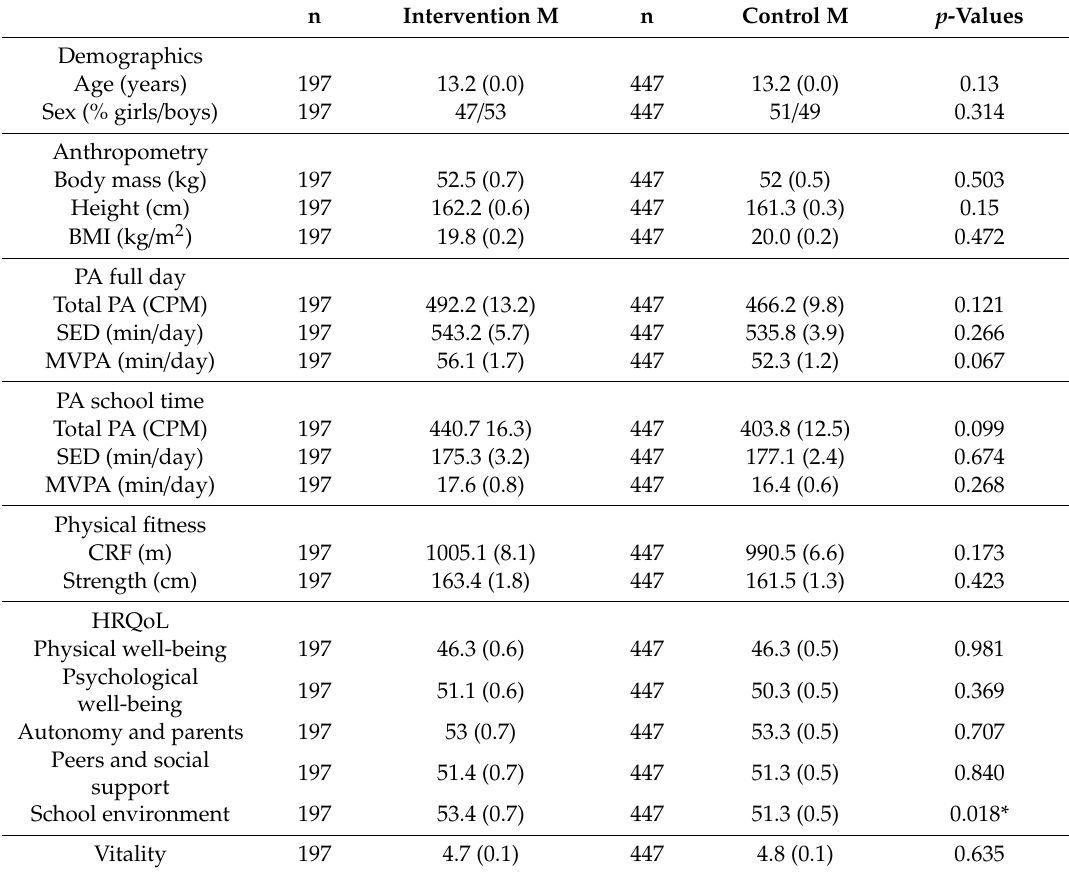
Table 2. Demographic data at baseline. Data are presented as means ( ± SE). n Intervention M n Control M p